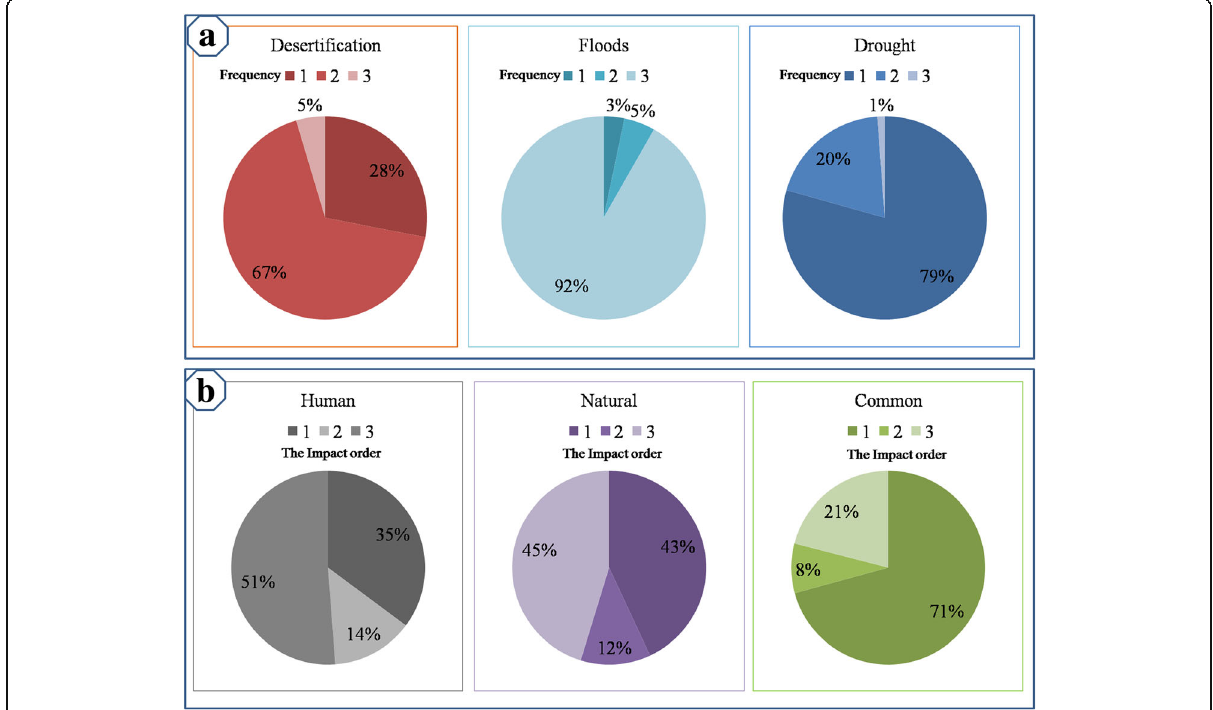
Fig. 4 a Drought and desertification frequency; b desertification causes